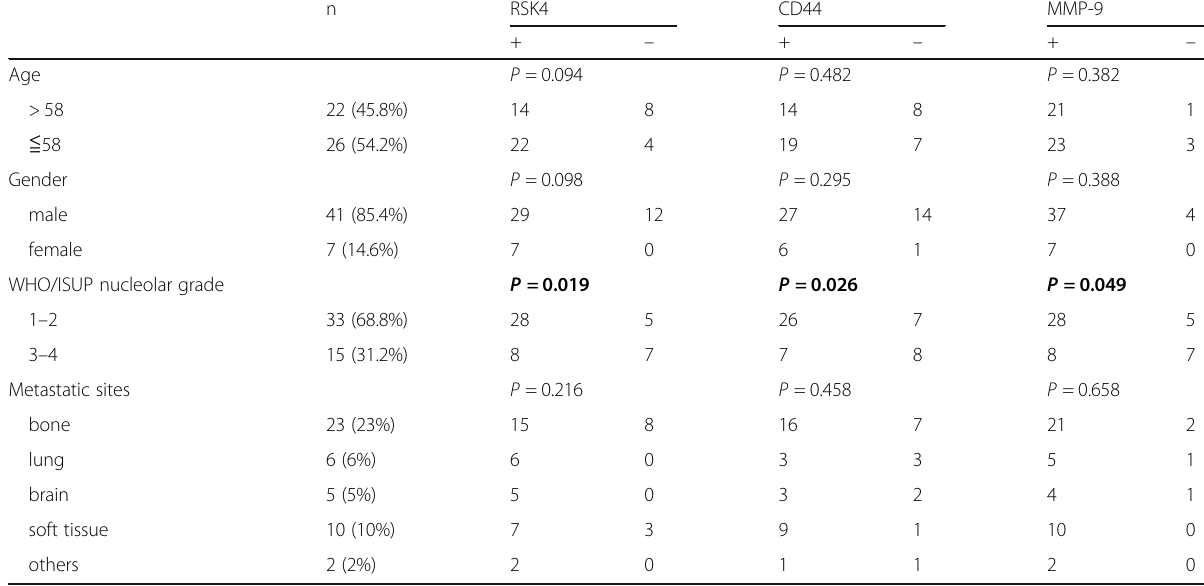
Table 3 RSK4, CD44 and MMP-9 immunostaining was cross tabulated with. Clinicopathological features of mRCC cases